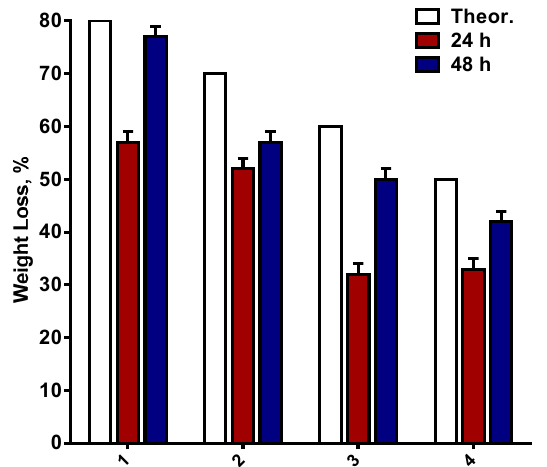
Figure 4. Dependence of the weight loss of PEO(80)/PLA(10)/BW(10) (1), PEO(70)/PLA(15)/BW(15) (2), PEO(60)/PLA(20)/BW(20) (3) and PEO(50)/PLA(25)/BW(25) (4) mats after a 24 or 48 h stay in distilled water. For comparison, the theoretical value of the weight loss, calculated based on the assumption that all PEO has been extracted from the corresponding mat in distilled water, is given as well.